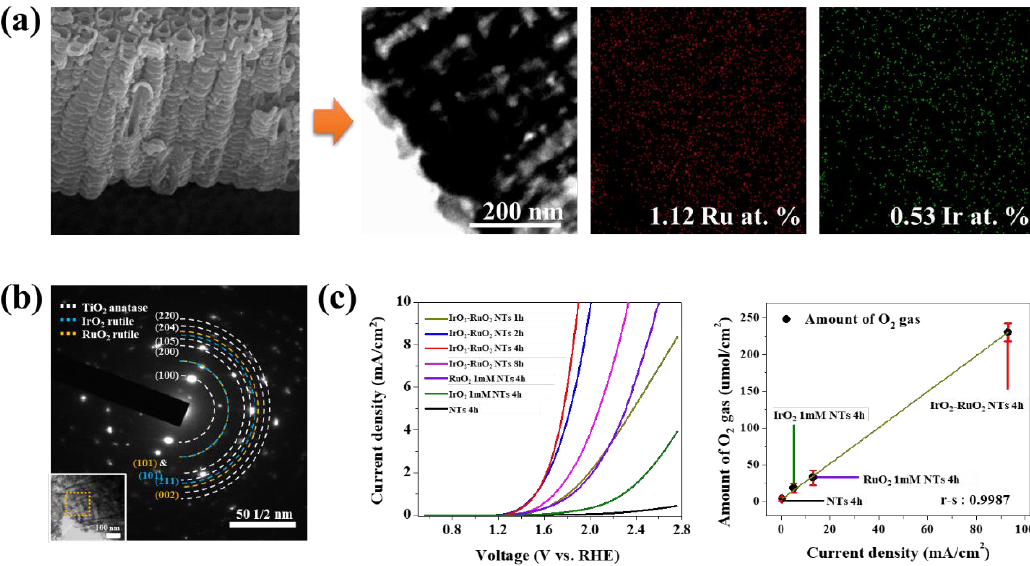
Figure 8. Morphological characterization data of IrO 2 -RuO 2 -doped TiO 2 nanotubes and the corresponding OER performance results. The elements ( a ) Ru (red spot) and Ir (green spot) are evenly distributed throughout the TiO 2 . ( b ) The nanotubes are polycrystalline, with the rutile phase of RuO 2 and IrO 2 well-dispersed in TiO 2 anatase phase. ( c ) LSV graphs showing overpotentials and gas chromatography mass spectroscopy (GC-MS) results measured for different nanotube materials in identical alkaline OER tests. Reproduced with permission from reference [31]. Inha University (2018).